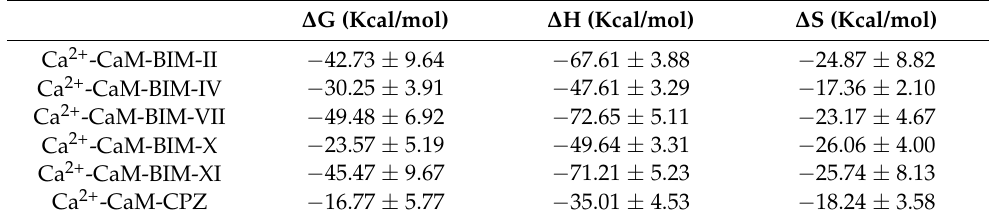
Table 3. Theoretical energy parameters of the Ca 2+ -CaM-BIM complexes from the MD studies.